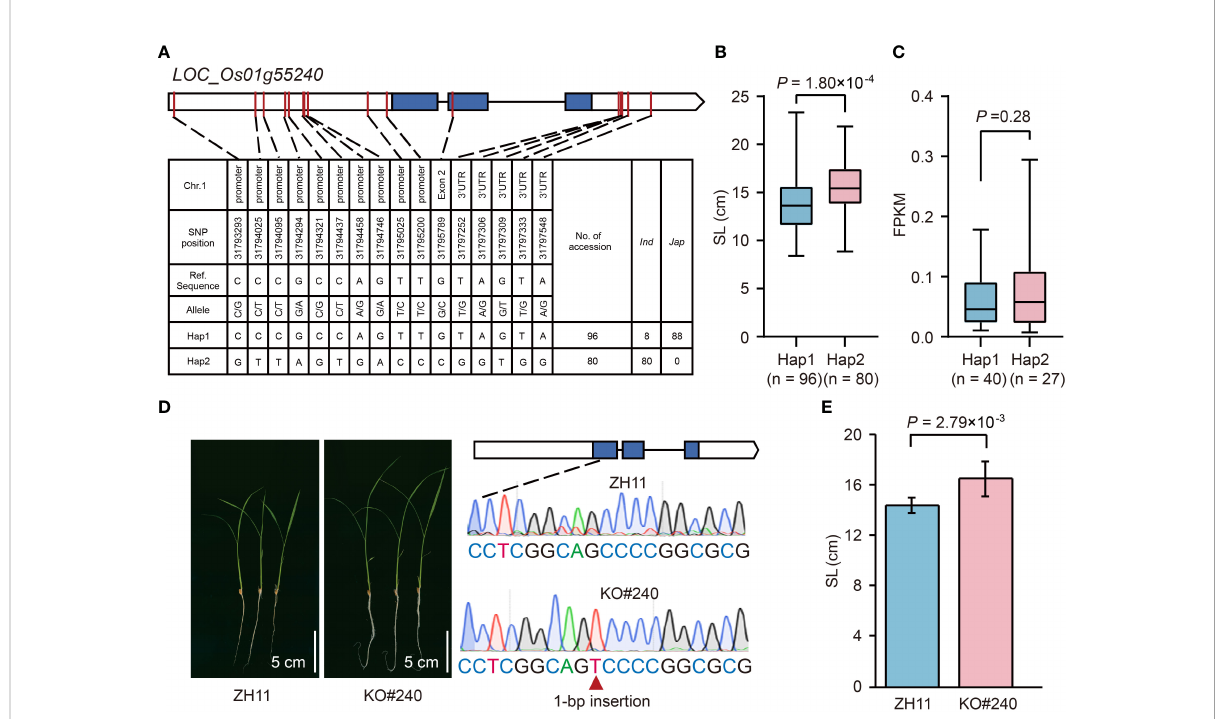
FIGURE 6 Effects of LOC_Os01g55240 on rice seedling growth. (A) The top two haplotypes of LOC_Os01g55240 in 346 rice accessions. The blue box represents the exon, the white box indicates 2-kb upstream region of the start codon or 1-kb downstream region of the stop codon, and the black line represents the intron. (B) Comparison of SL between accessions with Hap1 and Hap2. (C) Comparison of gene expression in leaves between accessions with Hap1 and Hap2. The mean FPKM value of three replicates is represented as the gene expression value for each accession. (D) Comparison of seedling growth status after imbibition for ten days between LOC_Os01g55240 gene-edited mutant (KO#240) and its wild-type ZH11. (E) Comparison of SL between KO#240 and ZH11. Data represent mean ± SD from ten replicate. The p-value is obtained from the